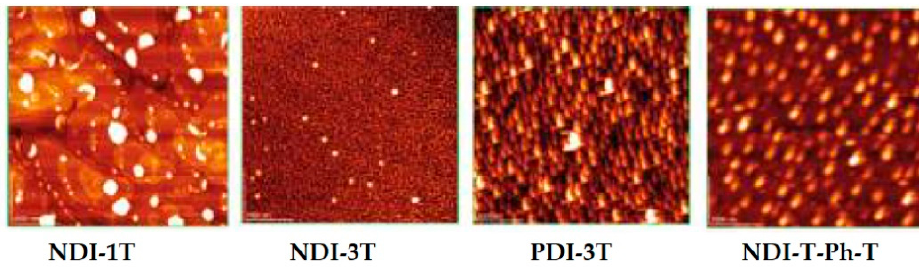
Figure 4. AFM images of vapor-deposited films of NDI-1T ( T d = 110 ◦ C on HMDS), NDI-3T ( T d = 25 ◦ C on HMDS-treated Si/SiO 2 substrates), PDI-3T ( T d = 110 ◦ C on HMDS) and NDI-T-Ph-T ( T d = 25 ◦ C on OTS-treated Si/SiO 2 substrates). Adapted with permission from J. Am. Chem. Soc . 2010 , 132 , 24, 8440–8452. Copyright© 2010 American Chemical Society [12].